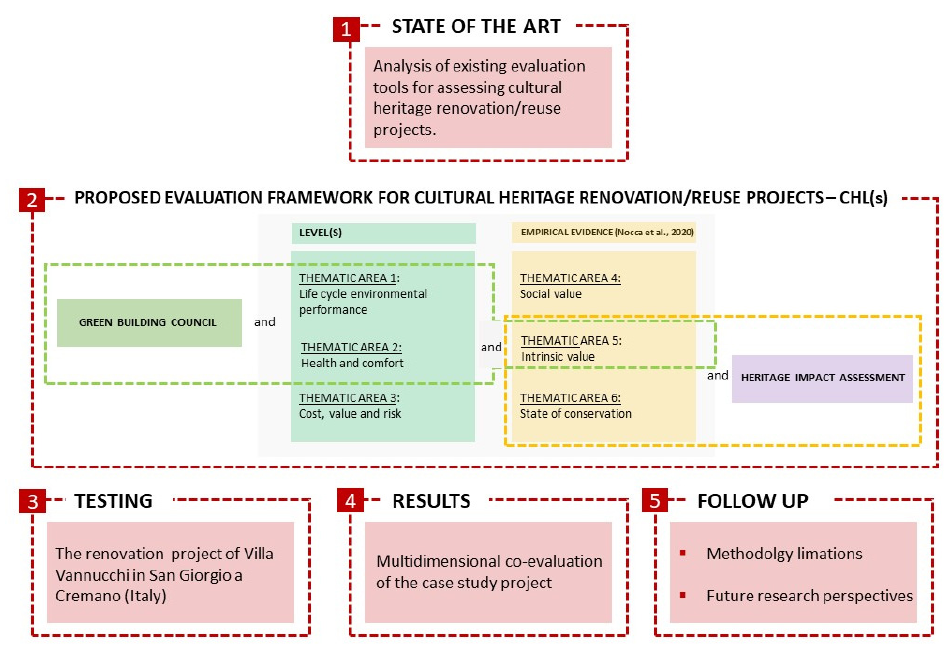
Figure 1. The methodological workflow.